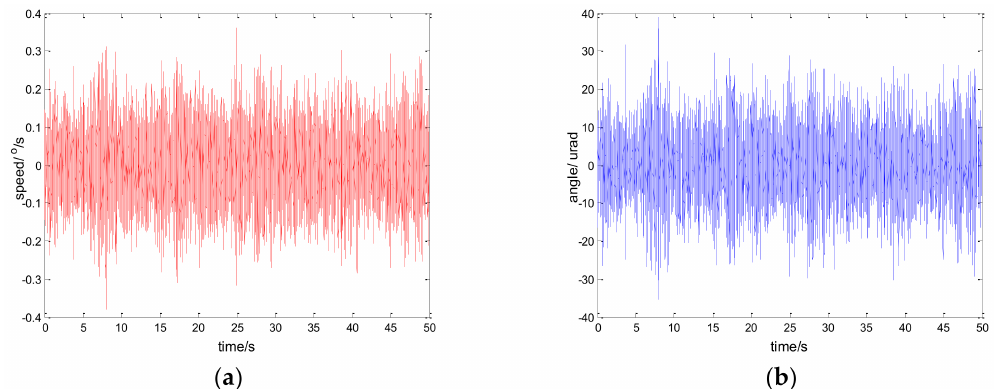
Figure 17. Experiment results of robust SMC with NTD. d = 6sin ( 2 π × 0.1 t ) : ( a ) speed; and ( b ) tracking error, RMS = 8.4473 urad.